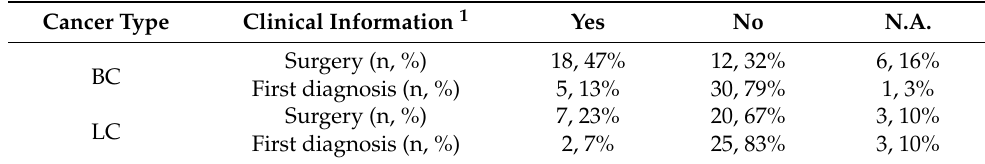
Table 2. Summary data of the BC and LC patients. Cancer Type